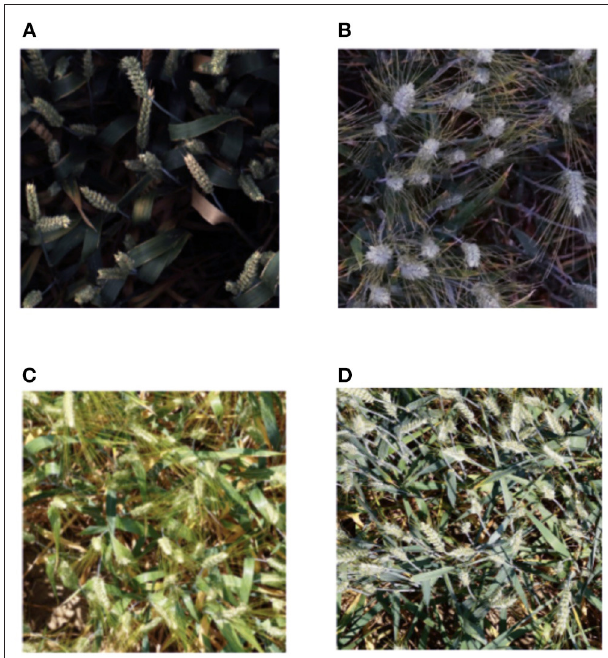
FIGURE 1 | The data set contains pictures taken under various weather conditions, illumination, and growth stages of wheat. (A) Photograph taken under shading during the wheat filling stage. (B) Photograph taken in half sunshine during the wheat flowering stage. (C) Photograph taken in full sunlight during the heading stage of wheat. (D) Photograph taken in full sunshine during the flowering stage of wheat.